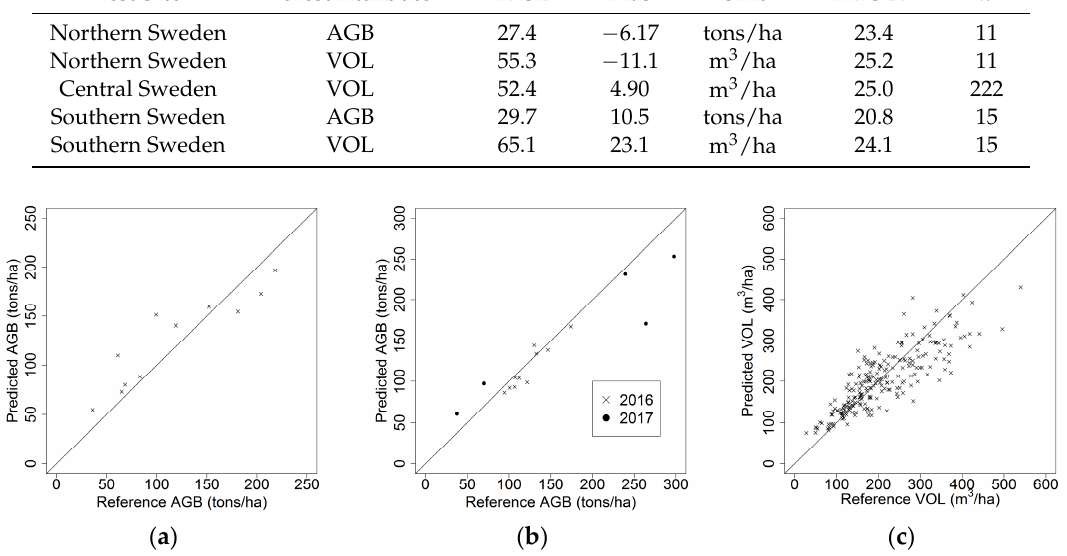
Figure 18. Evaluation of predicted AGB from TanDEM-X after growing season 2015 vs. ( a ) 11 field inventoried stands in northern Sweden 2016. ( b ) Fifteen field inventoried stands across southern Sweden. Ten stands were sampled with 10 plots/stand in 2016, while the remaining stands were sampled with 4 plots/stand in 2017. ( c ) Two hundred twenty two company inventoried stands in central Sweden.